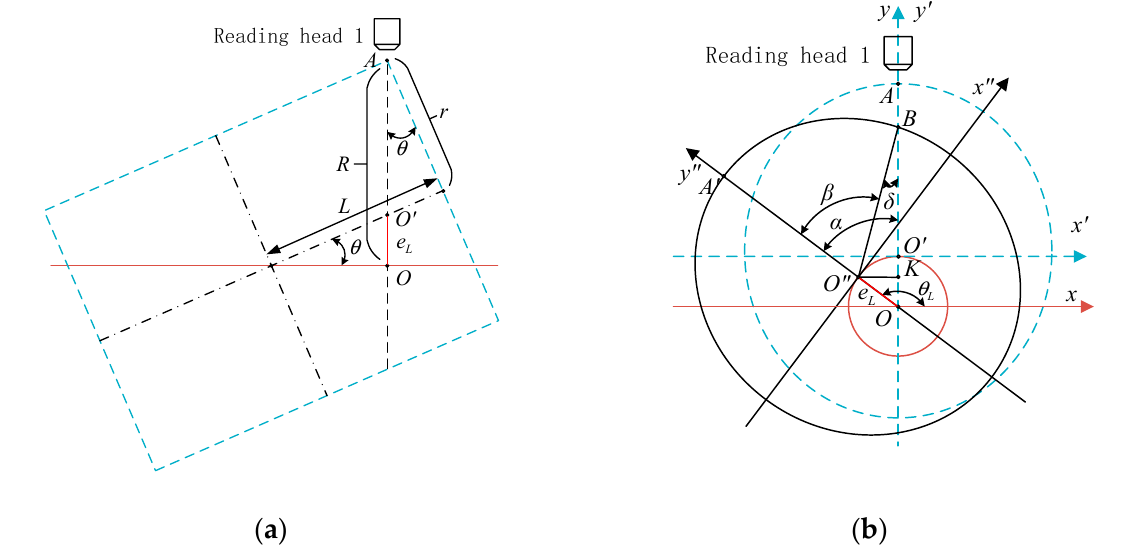
Figure 3. Schematic diagram of the inclination error of angle measurement with a single reading head. ( a ) Axial section of the shafting; ( b ) reading section of the shafting.